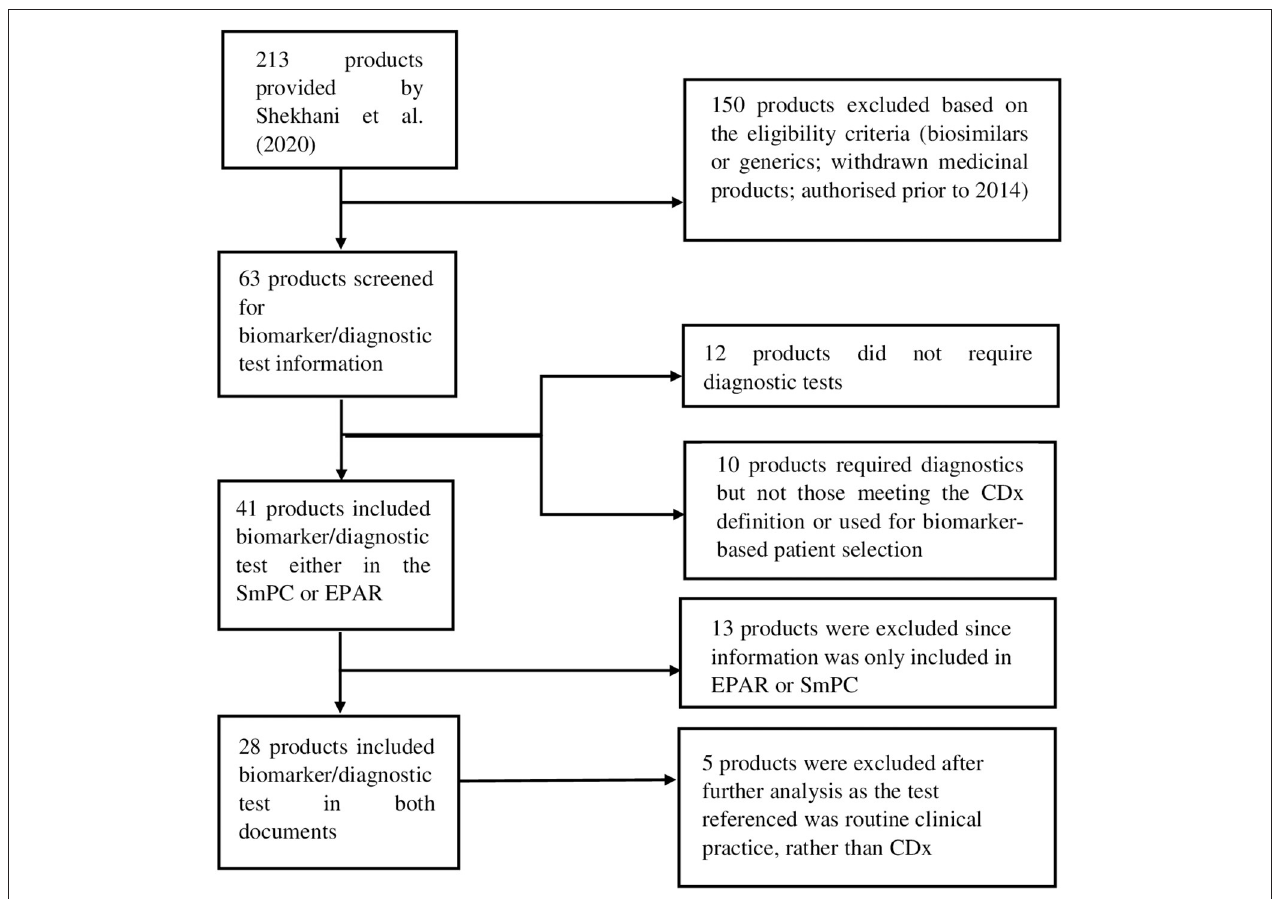
FIGURE 1 | Flow diagram showing the selection process of included medicinal products and eligibility criteria.